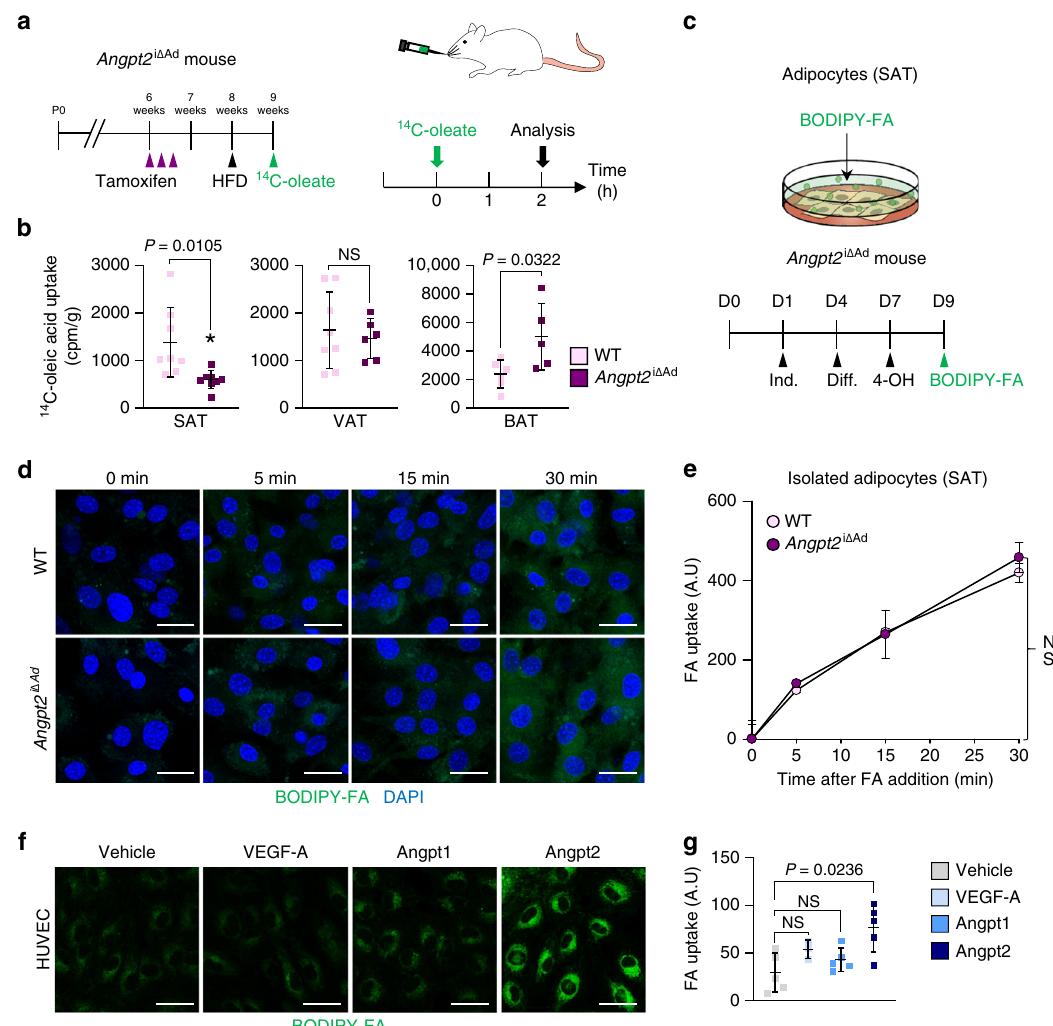
Fig. 2 Angpt2 stimulates endothelial FA uptake. a Diagram depicting the experiment scheme for examining fatty acid ( 14 C-oleate) transport into different adipose tissues in Angpt2 i Δ Ad mice delivered with tamoxifen into 6 week old mice and HFD from 8 week old mice and their analyses in 9 week old mice. Adipose tissues were harvested 2 h after oral gavage of 2 mCi of 14 C-oleate dissolved in 200 µ l olive oil. b Comparisons of 14 C-oleic acid uptake in different adipose tissues in WT and Angpt2 i Δ Ad mice. Each dot indicates a value obtained from one mouse using n = 8(SAT), 8(VAT WT), 6(VAT Angpt2 i Δ Ad ), 6 (BAT WT), and 5(BAT Angpt2 i Δ Ad ) mice/group pooled from two independent experiments. Horizontal bars indicate mean ± SD and P values versus WT by two-tailed Student ’ s t test. NS not signi fi cant. c Diagram depicting FA uptake of primary cultured adipocytes between WT and Angpt2 i Δ Ad mice. SVF of SAT from WT and Angpt2 i Δ Ad mice were isolated and cultured until con fl uence with adipocyte induction and differentiation medium at indicated days. After 2 days of 4-OH treatment to delete Angpt2 , cells were analyzed for FA uptake. d , e Representative images and comparisons of FA (BODIPY C-12, 0.75 µ M) uptake at indicated time points in primary cultured adipocytes from SAT of WT and Angpt2 i Δ Ad mice. Each dot indicates a value obtained from one mouse using n = 3 mice/group pooled from two independent experiments. Horizontal bars indicate mean ± SEM. NS not signi fi cant. Scale bars, 30 μ m. f , g Representative images and comparisons of FA (BODIPY C-12, 8 µ M) uptake in HUVECs after treatment with VEGF-A (40 ng/ml), Angpt1 (200 ng/ml), or Angpt2 (2.5 μ g/ml) for 30 min. n = 3 (VEGF-A), 5(Vehicle, Angpt1, Angpt2) for each group. Horizontal bars indicate mean ± SD and P values versus vehicle by one-way ANOVA followed by Tukey ’ s multiple comparison test. Scale bars, 30 μ